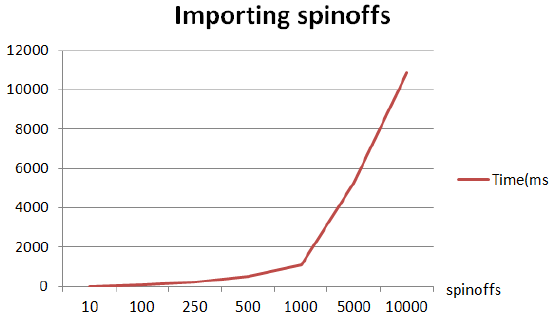
Fig. 4 Efficiency analysis of the importing spin-offs process